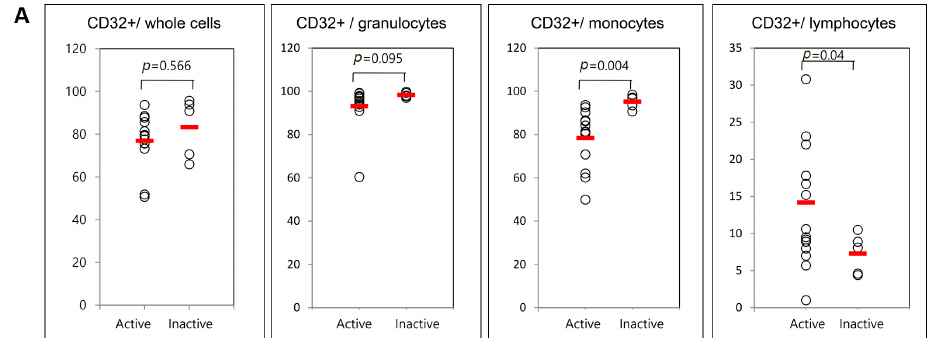
Figure 4. Flow cytometric results of the percentage of surface-stained cells presenting CD32 ( A ); CD206 ( B ); CD209 ( C ); and dectin-1 ( D ) according to disease activity in patients with AOSD. The results were obtained from 18 samples from AOSD patients. Thirteen active, untreated AOSD patients were included, and follow-up samples were collected from five patients after their disease activity resolved. The horizontal line indicates the mean value for each group. The p -value was determined with the Mann–Whitney U -test.